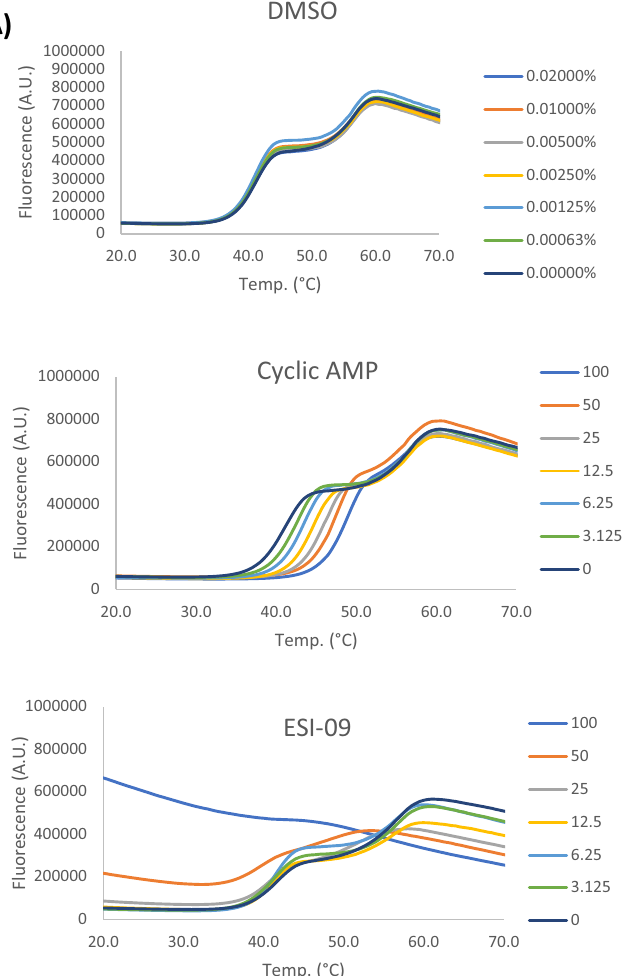
Figure 1. Thermal shift profiles of EPAC1 ligands. ( A ) A dilution series of cAMP or ESI-09 (3.125–100 µM range) plus diluent (DMSO; concentrations as indicated in graph) were prepared and combined with 2 µM GST- EPAC1-CNBD and 10 × SYPRO Orange dye, in a PCR-compatible microplate. Plates were incubated overnight at 4 °C, and then subjected to a standard temperature gradient programme using a real-time PCR machine, with a temperature range of 11–80 °C, ramping up in 0.5 °C increments, with a 30-s hold at each temperature Changes in fluorescence of SYPRO Orange then were monitored. A 20–70 °C range is shown in the graphs. Presented data is an average of three independent experiments. ( B ) Thermal shift assays (TSA) were carried out on a dilution series of I942 (3.125–100 µM range) and selected chemical analogues, as described in the legend to ( A ). ( C ) TSAs were carried out on a dilution series of “SY” series analogues (3.125–100 µM range) and selected chemical analogues, as described in the legend to ( A ). ( D ) Tm values for 100 μM ligand concentration from the TSAs carried out in ( A – C ) are displayed as a bar graph. Significant differences in Tm values relative to cyclic AMP are indicated, **p < 0.01 and ***p < 0.001, or ns, for no significant difference (n =